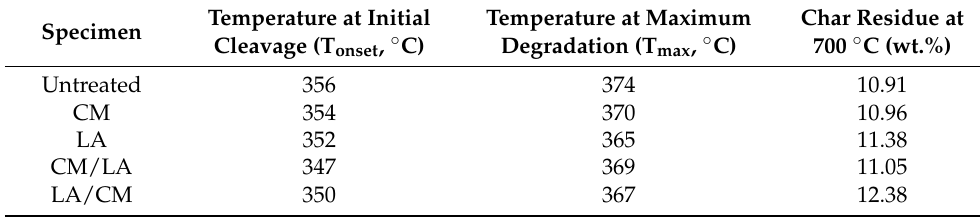
Figure 5. ( a ) TGA and ( b ) DTG curves of untreated and treated samples. Table 2. Thermal stabilities of samples.